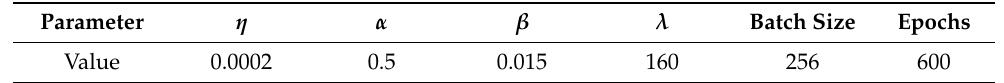
Table 4. Hyperparameters of training the